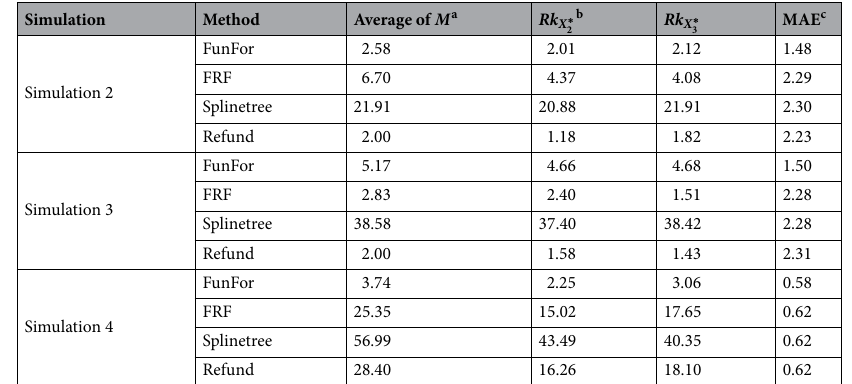
b Rk stands for the average rank of each true c MAE is the prediction error. The smaller, the better.